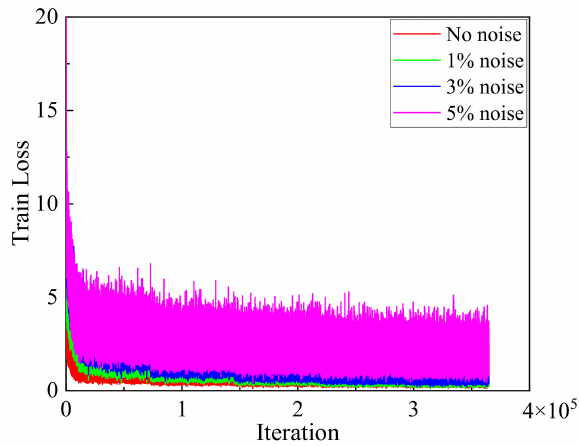
Figure 6. The training curves of ASCE benchmark frame.